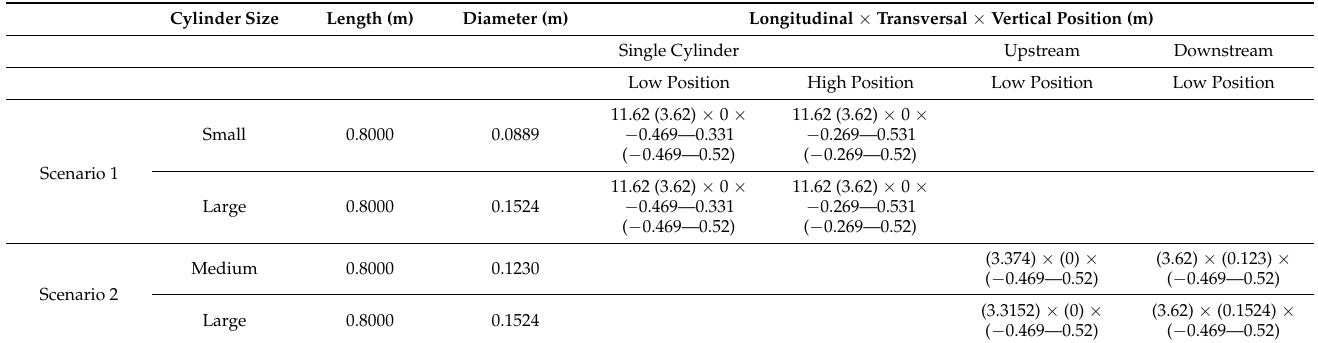
Table 2. Cylinder particulars describing the arrangement for the cylinders in the experimental setup and for the numerical setup (in